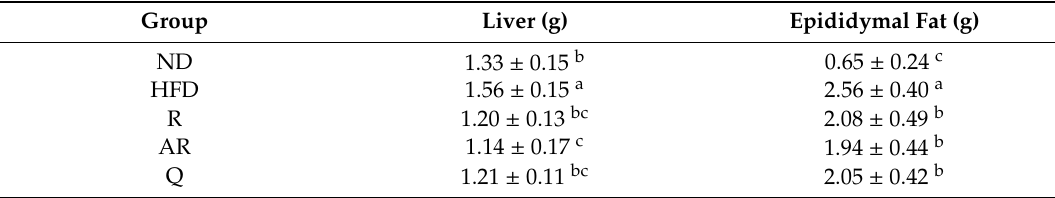
Table 4. E ff ect of experimental diets on liver and epididymal fat weight in mice.